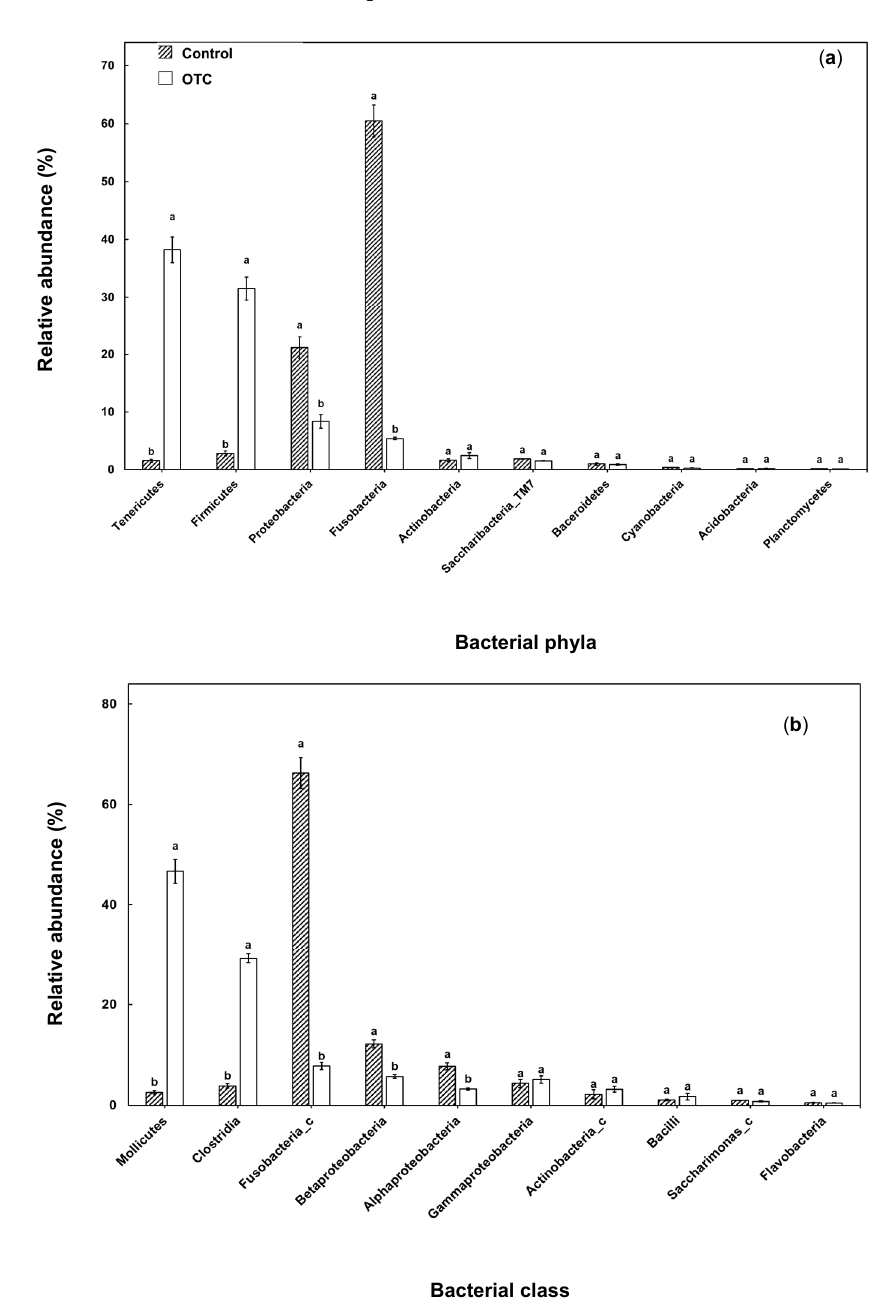
Figure 2. Relative abundances of the 10 most abundant gut bacterial phyla ( a ) and class ( b ) in rainbow trout. Different letters indicate significant differences among taxa at p < 0.05 by Tukey’s test.